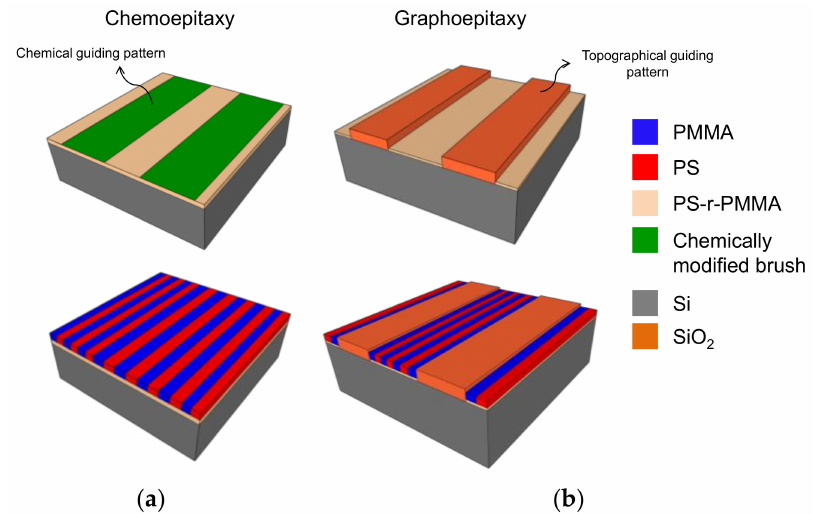
Figure 2. Schematic of DSA by chemo- and graphoepitaxy. ( a ) In chemoepitaxy, areas of the substrate are chemically activated to show stronger a ffi nity to one of the blocks, directing the self-assembly; ( b ) in graphoepitaxy, the substrate is topographically structured to direct the